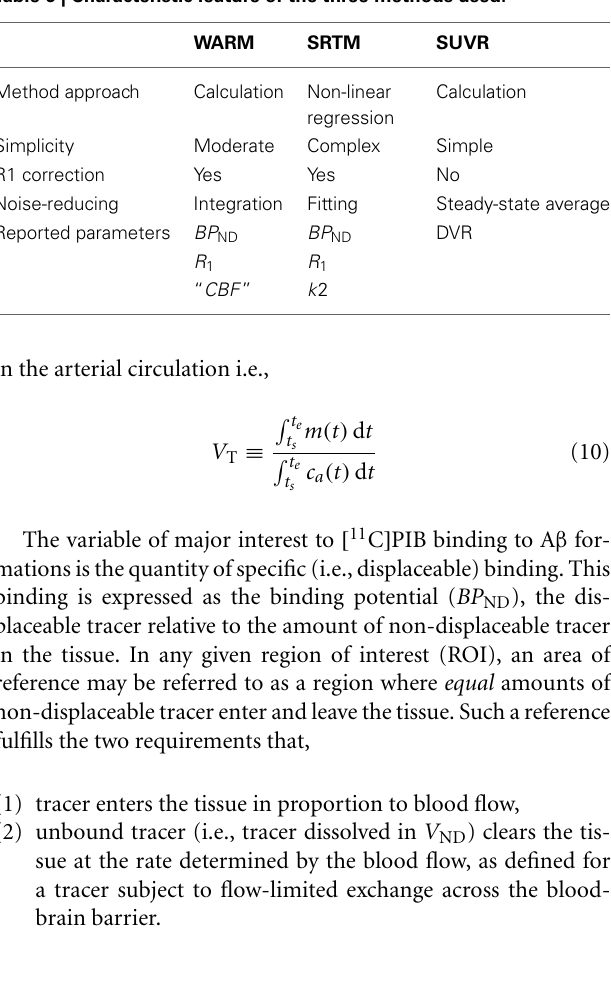
FIGURE 7 | The figure shows the average washout index (cid:2) image calculated over the time interval T = 1890s for all subjects. Mean values > 1660s, superimposed on a non-linear